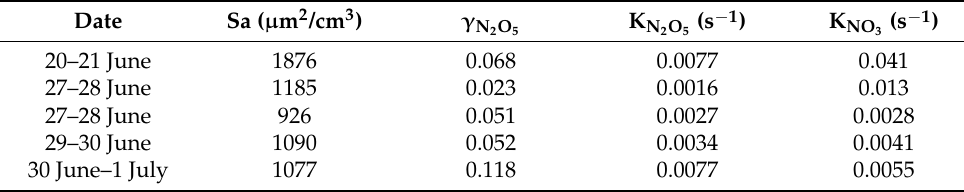
), and k N 3 2 O 5 ), and k N 2O . 3 5